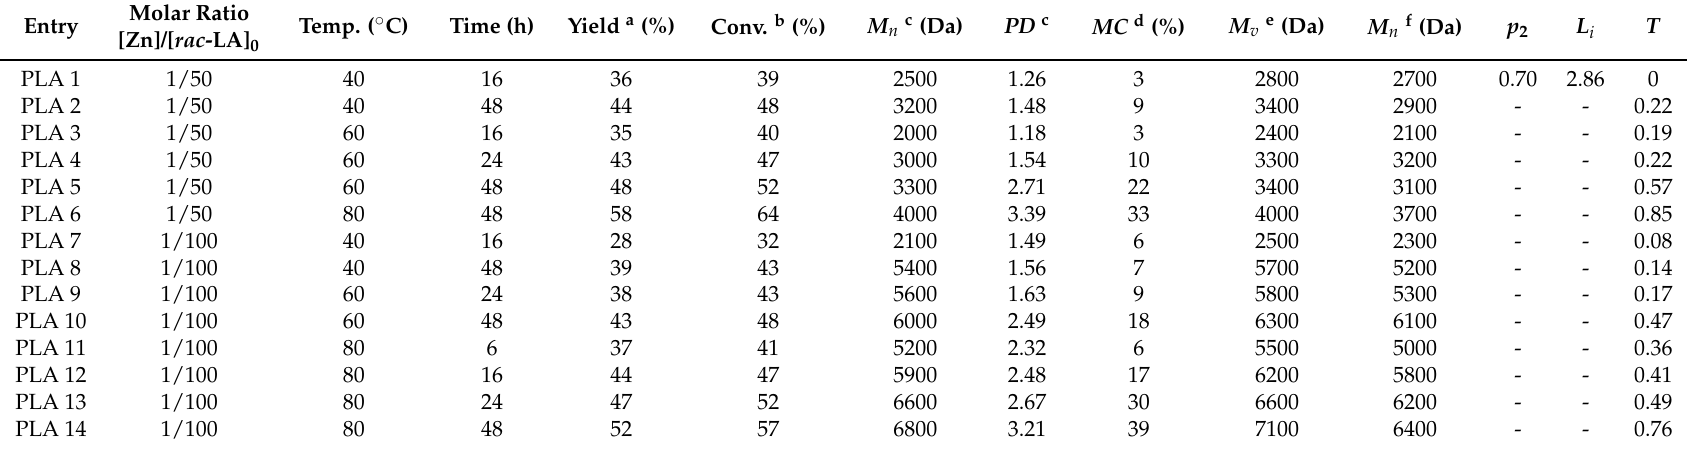
Table 1. Ring-opening polymerization of rac -LA in toluene in the presence of ZnEt 2 /GAc catalytic system.